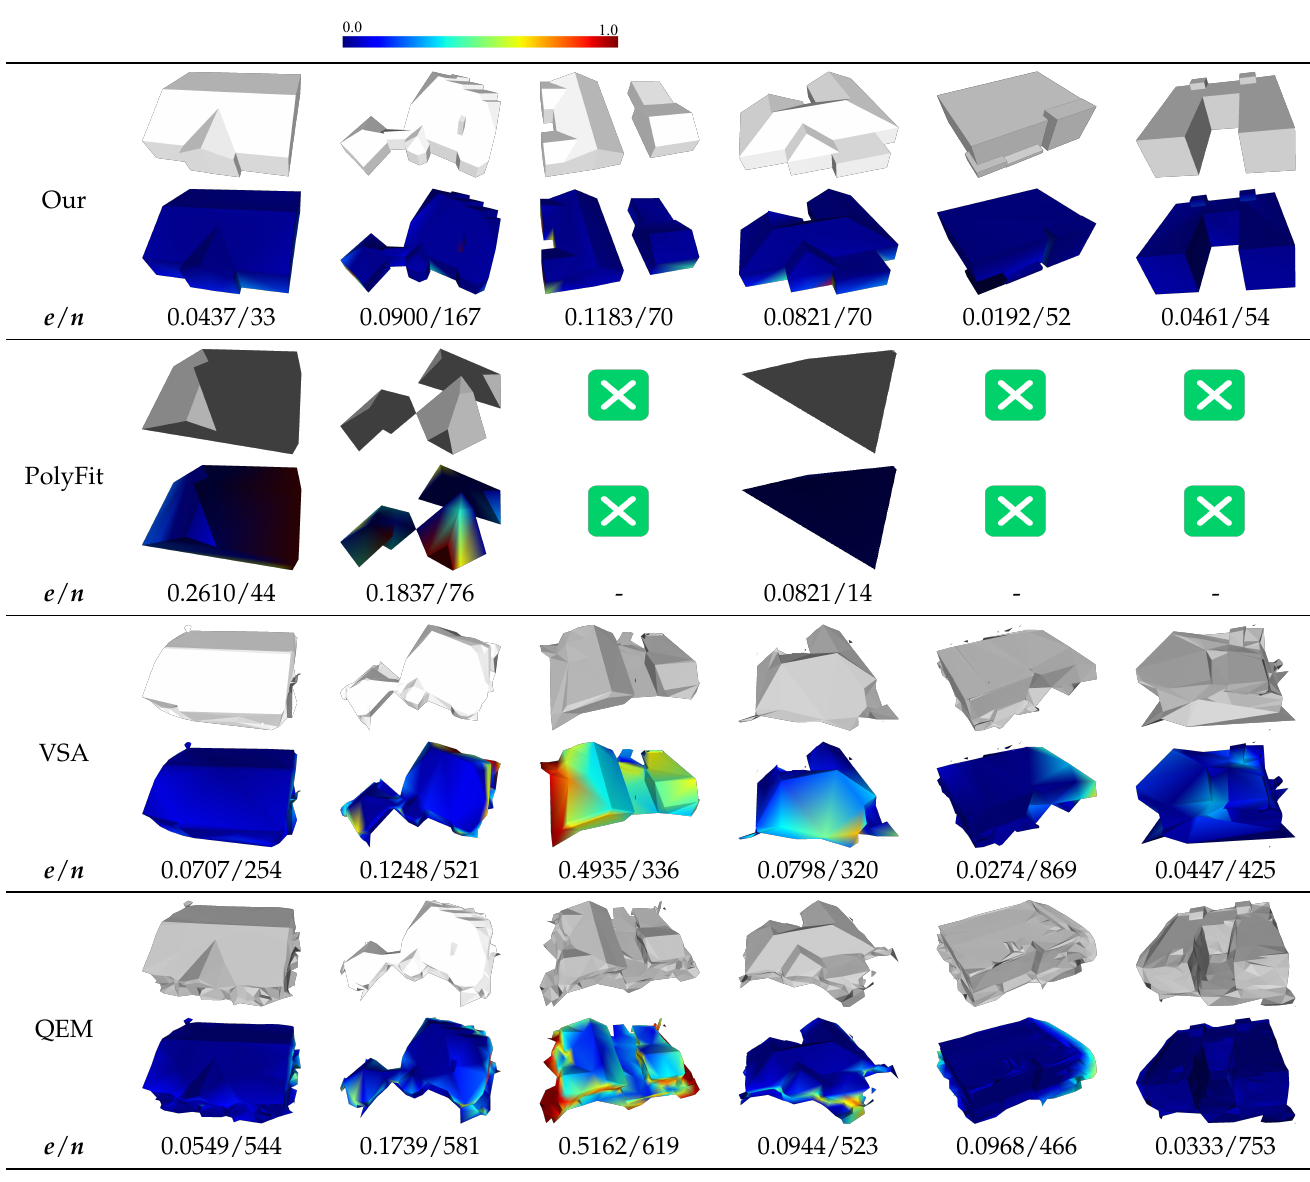
Table 3. Modeling results on Dataset I for our method, PolyFit [11], VSA [4], and QEM [5]. For each modeling result, the mean Hausdorff distance e (m) is computed from the output to the original point cloud. Furthermore, the n is the number of facets in the generated model. For the largely missing point clouds in our datasets, PolyFit failed to generate the model on several buildings, which are marked with green